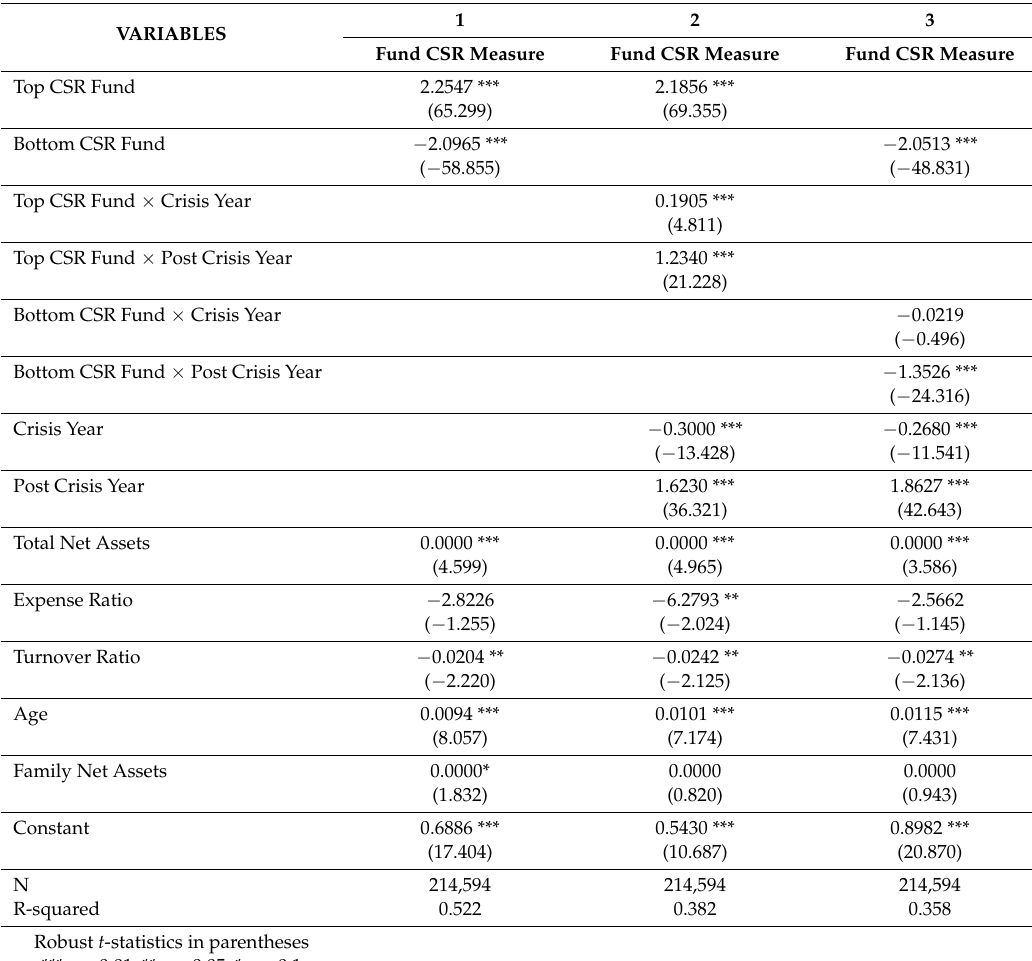
Table 6. Fund CSR measure, financial crisis and post-crisis